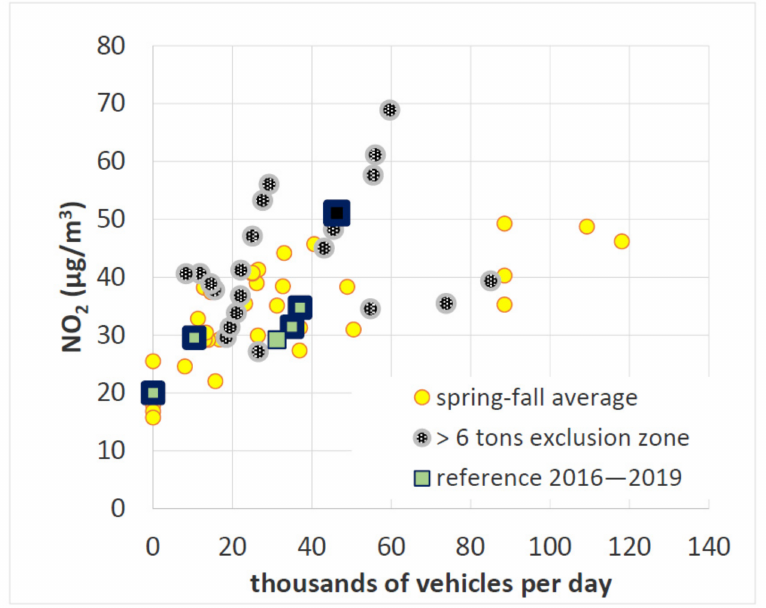
Figure 6. Relationship between traffic intensity and NO 2 concentrations measured by passive samplers (average of all measurement periods) and by the national monitoring network (average of 2016–2019).